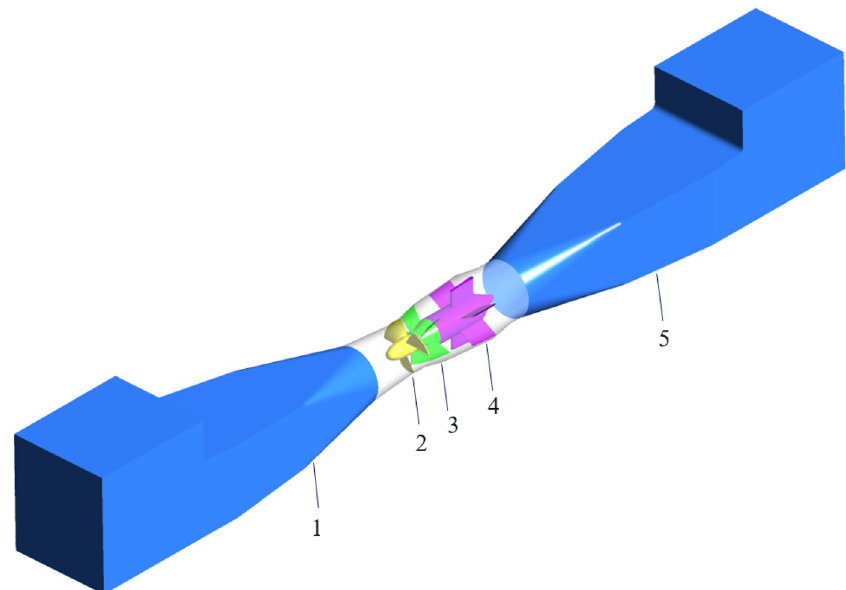
Figure 2. Three-dimensional schematic diagram of the model pump system